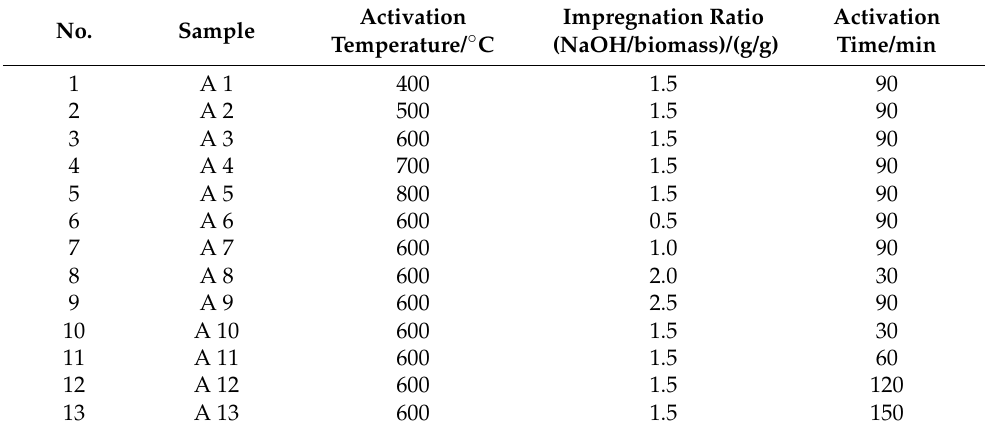
Table 3. The factorial design of experimental runs and conditions of activation of carbon with